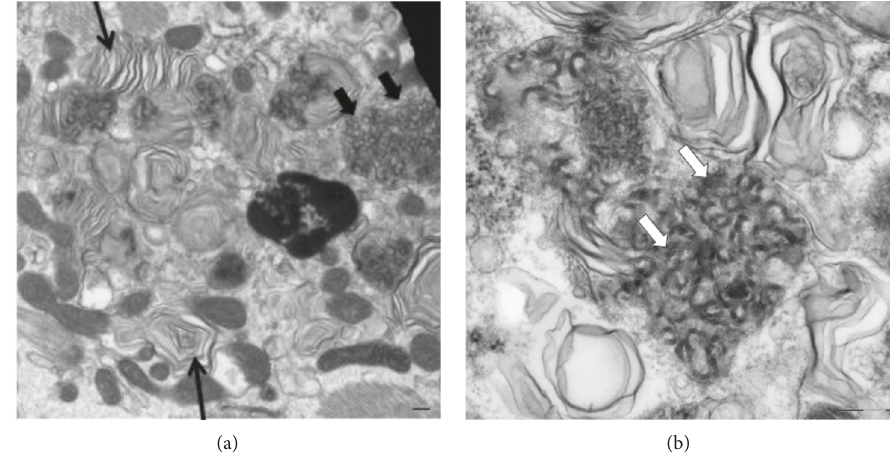
Figure 2: On the left (a), an electron micrograph of endomyocardial biopsy with myeloid bodies (single black arrows) is present including a “zebra” type in the upper part of the figure. Curvilinear bodies (white double arrows) are also present. On the right (b), higher magnification of curvilinear bodies.